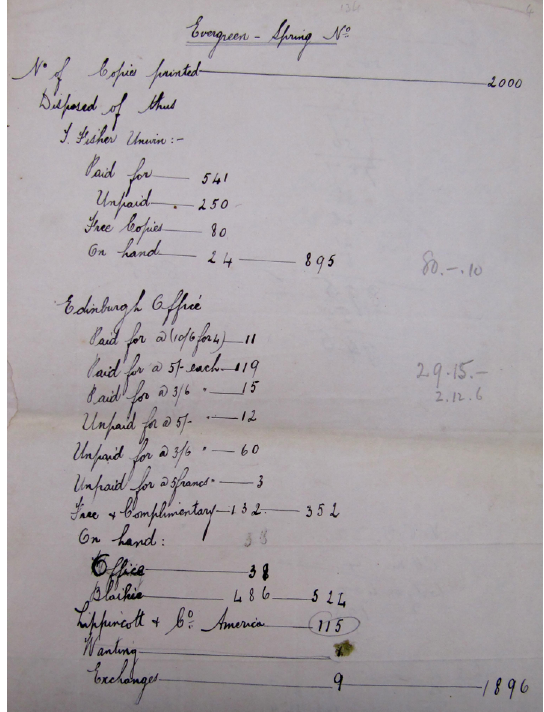
Fig. 9 Distribution of the copies of the ‘Evergreen – Spring N°’, SUA, T-GED 8/1/2, Glasgow, Strathclyde